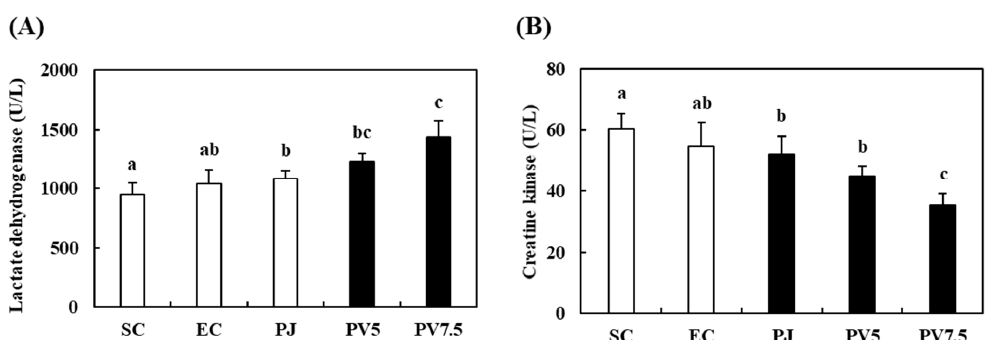
Figure 6. E ff ects of PV on ( A ) lactate dehydrogenase and ( B ) creatine kinase activities in rats exhausted by exercise. Data values are expressed as the means ± S.E. ( n = 6). SC: sedentary control, EC: exercised control, PJ: Prunus mume juice, PV5: 5% Prunus mume vinegar drink, PV7.5: 7.5% Prunus mume vinegar drink. Different letters on the bar are significantly different ( p < 0.05).